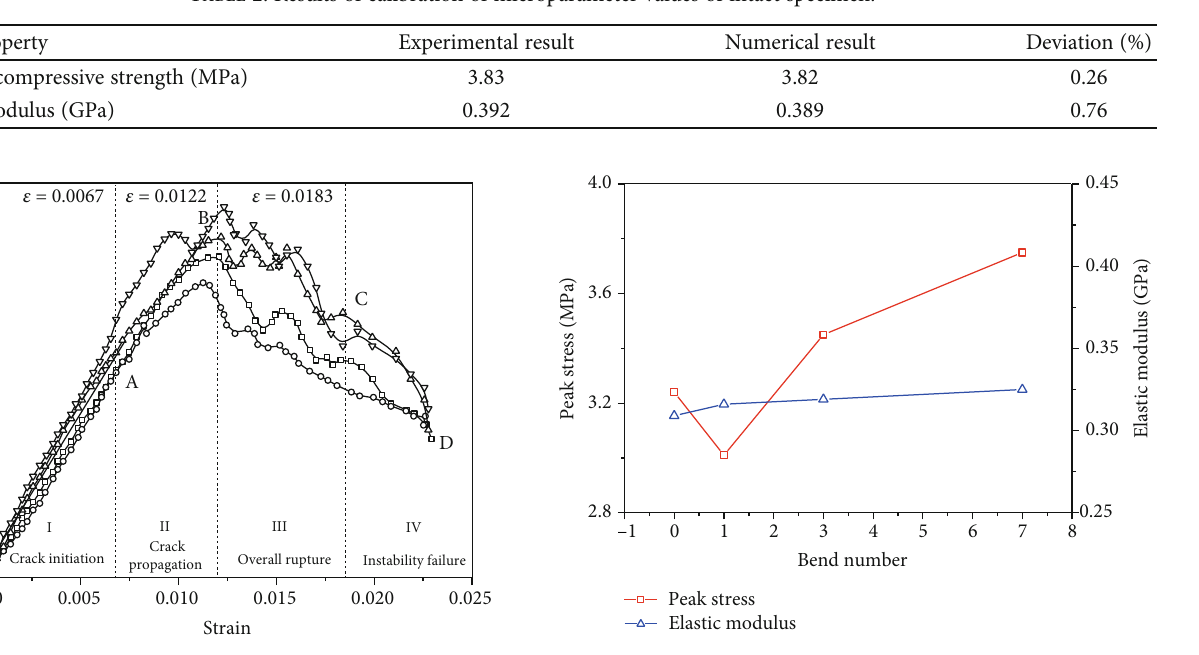
Figure 4: Curve of peak stress and elastic modulus changing with the bend